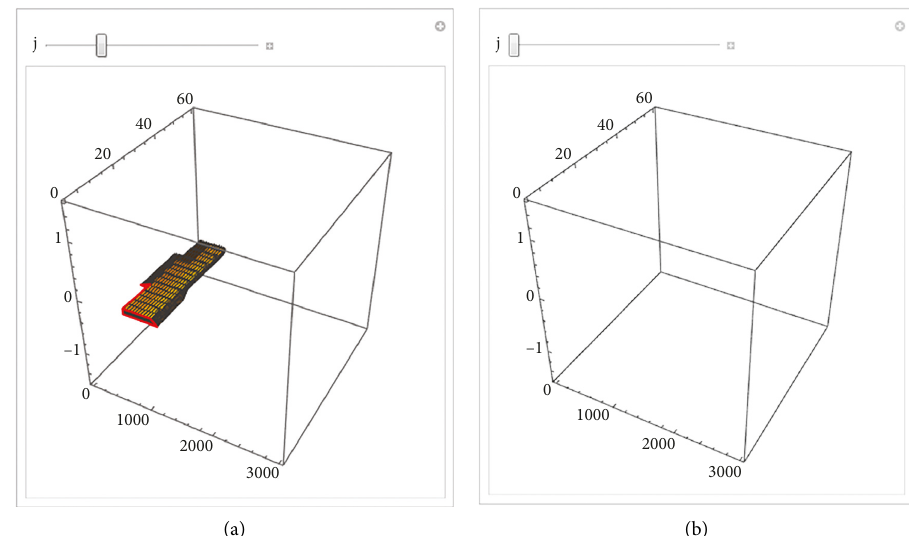
Figure 5: Solution domain graph of the inequality system. (a) Existence of a solution domain and (b) no solution domain.